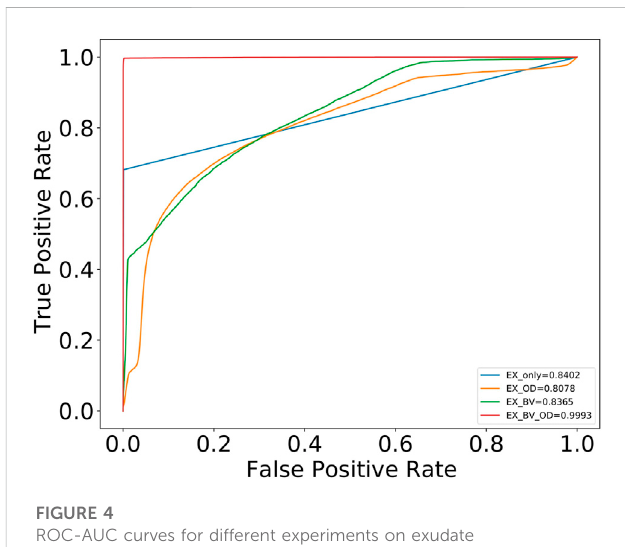
TABLE 2 Results of various multi-tasking experiments run on segmentation of exudates. Best results (shown in bold) were achieved when the model was trained with multi-tasking loss for a combination of exudates, the OD, and BVs. Experiments run